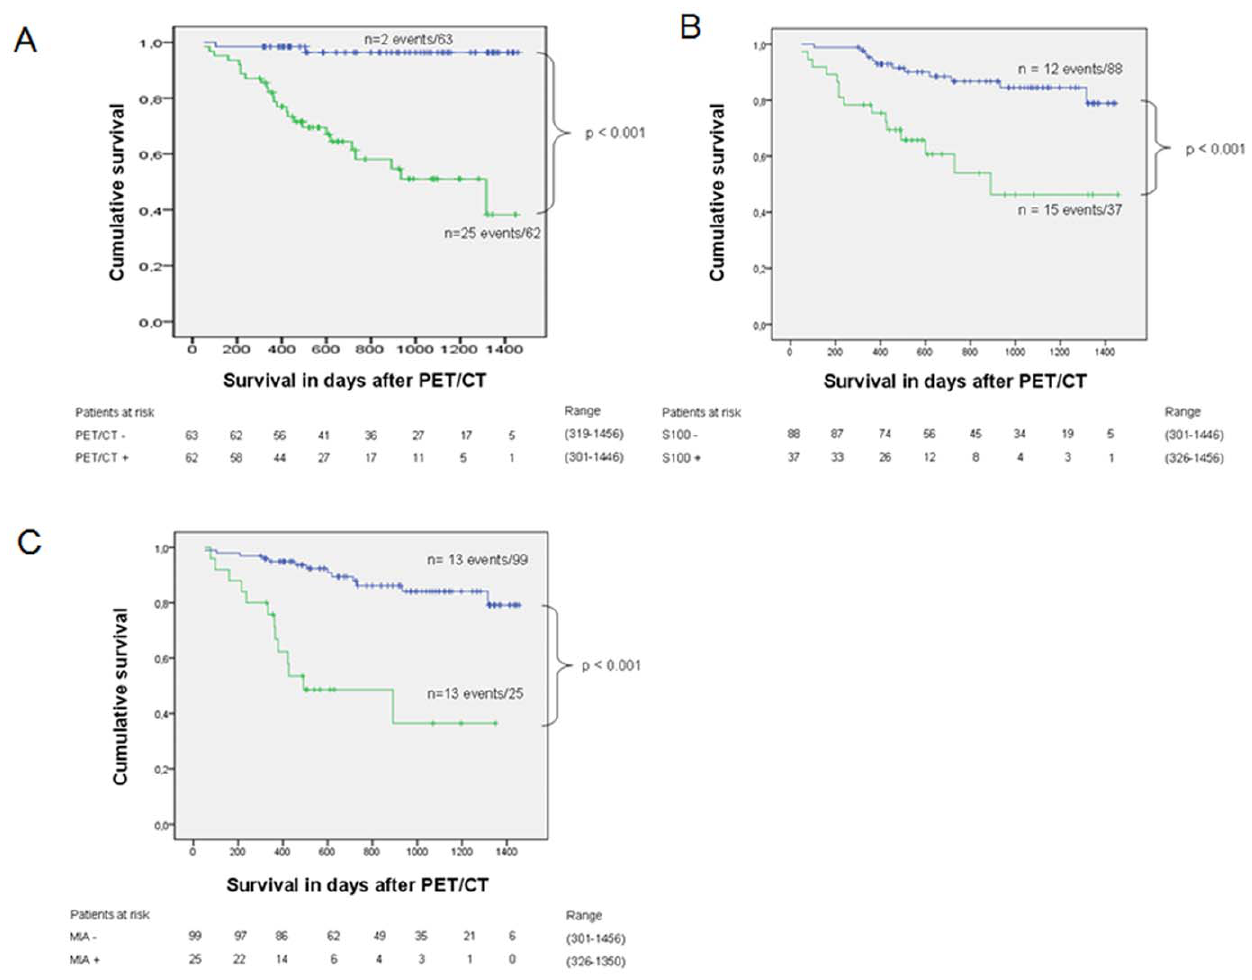
Figure 1. Correlationofsurvivalandpositivefindings in PET/CT (A), S100 (B) MIA (C) and LDH (D). Blue: patients with positive findings. Green: patients diagnosed negative.